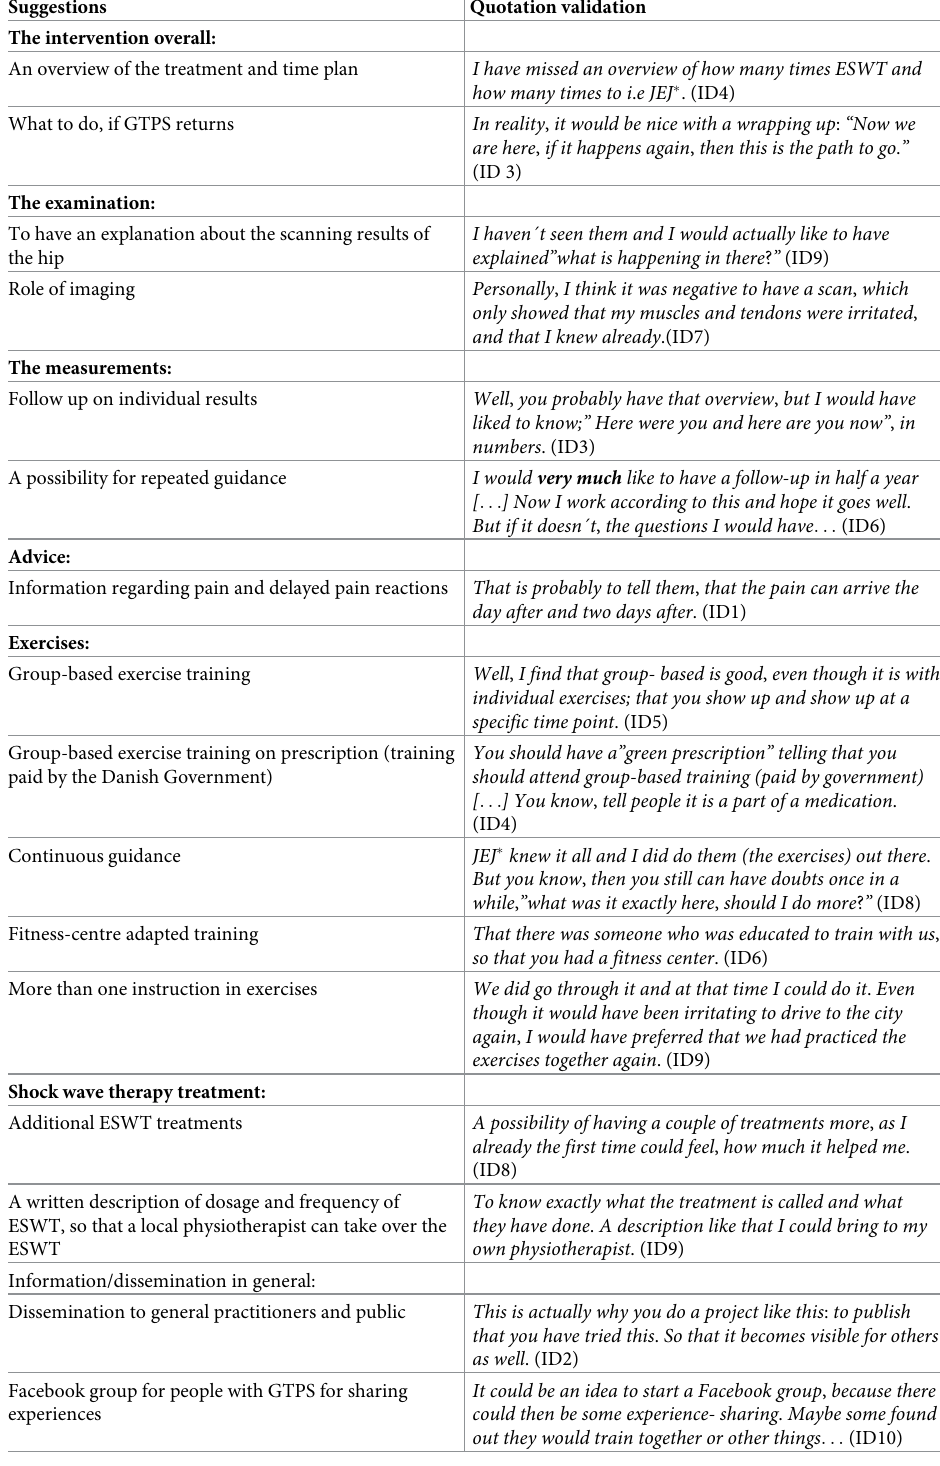
Table 3. Ways of improving care from the participants´